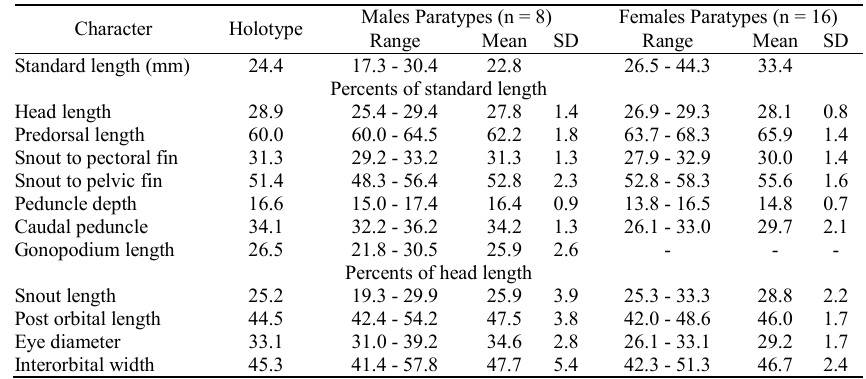
Table 1 . Descriptive morphometrics of Jenynsia luxata . SD = standard